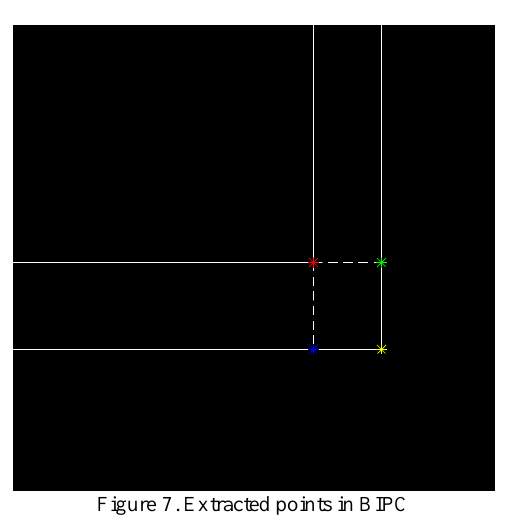
Figure 6. Extracted points in BCAD